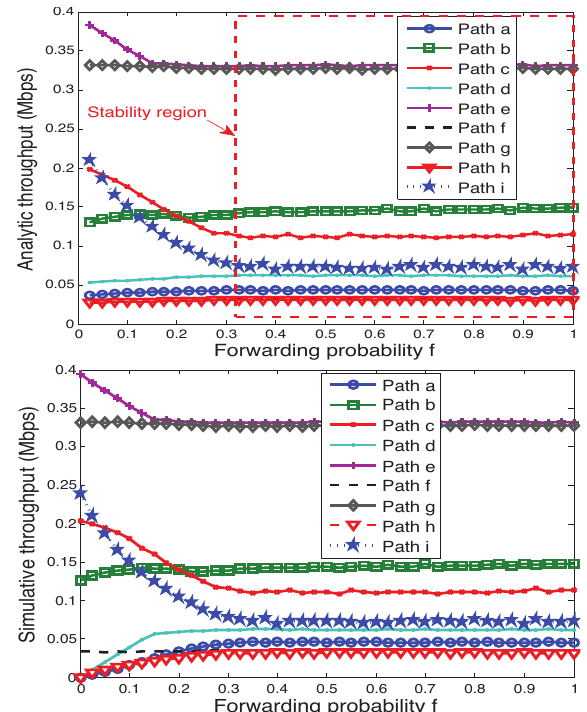
Figure 6. Average end-to-end throughput from model versus simulation as function of forwarding